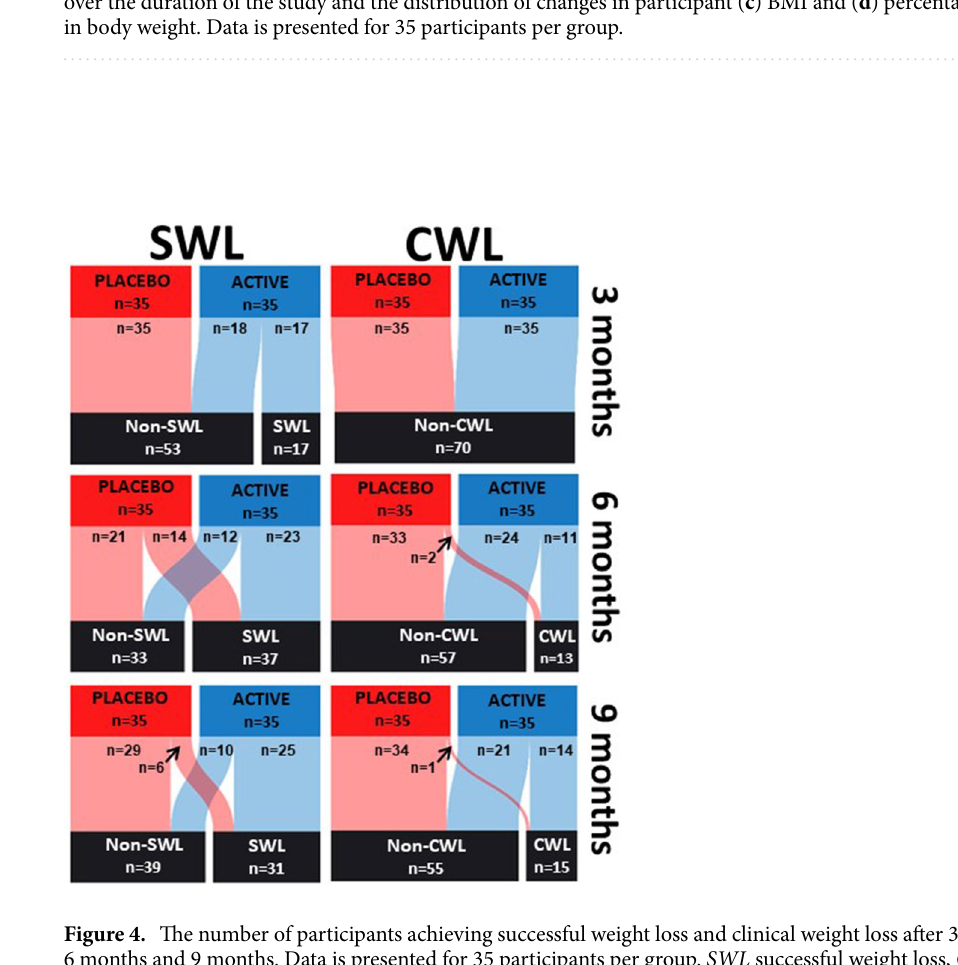
Figure 4. The number of participants achieving successful weight loss and clinical weight loss after 3 months, 6 months and 9 months. Data is presented for 35 participants per group. SWL successful weight loss, CWL clinical weight loss. Diagram created using sankeyMATIC (http://sanke ymati